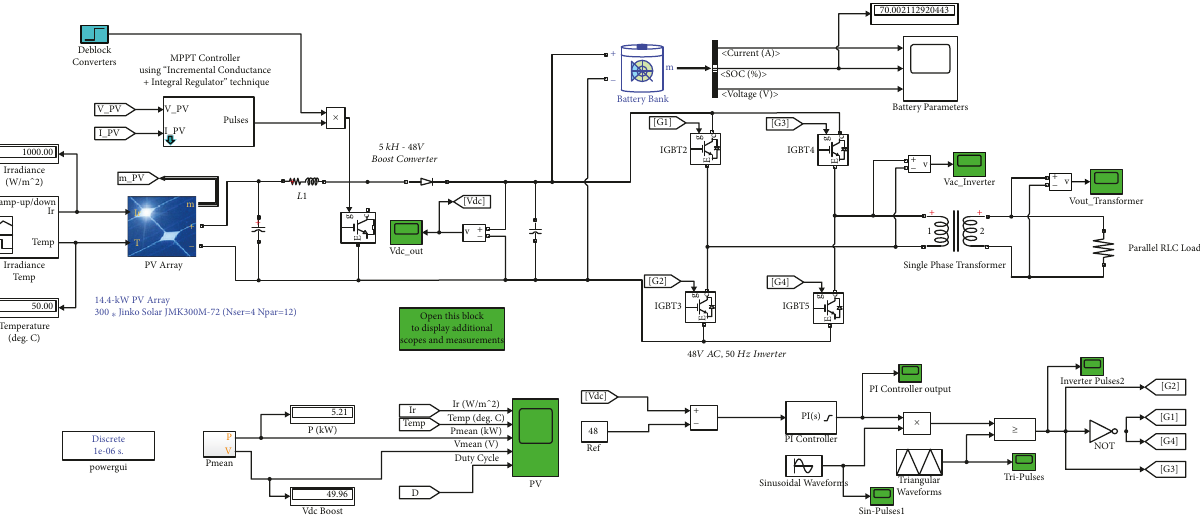
Figure 16: MATLAB/Simulink model of the proposed PV system.